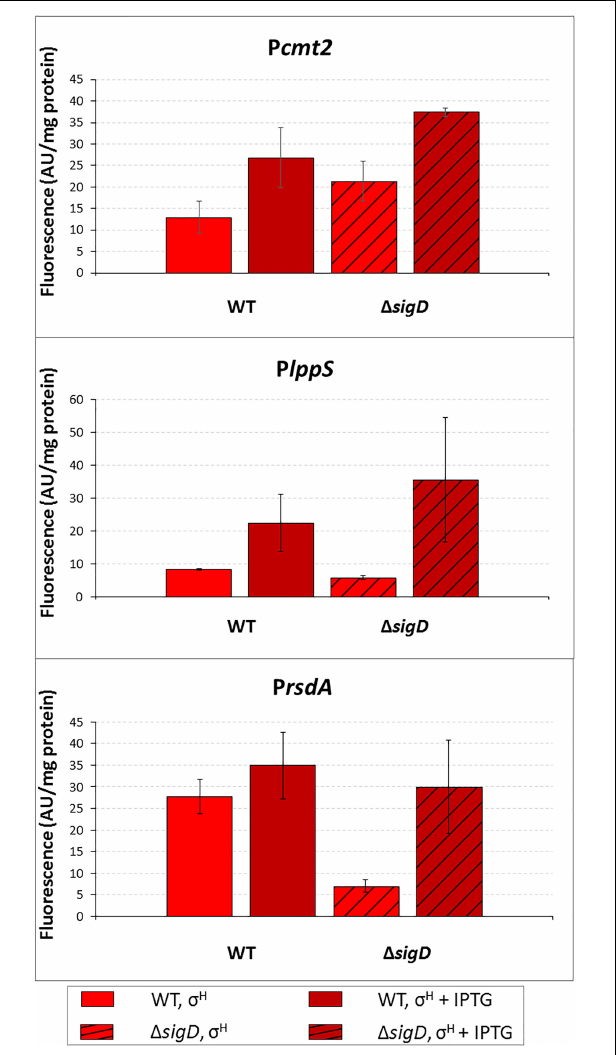
FIGURE 4 | Determination of promoter activity in C. glutamicum WT and (cid:49) sigD strains under sigH overexpression conditions using the two-plasmid assay. The C. glutamicum strains carried the vector pEC-XT99A construct overexpressing sigH with IPTG and the promoter-test vector pEPR1 with a target promoter P cmt2 , P lppS or P rsdA . The promoter activity was measured as the Gfpuv fluorescence intensity of the cell extracts after 6-h growth on complete agar plates with or without IPTG. Fluorescence of cultures without IPTG are shown as light bars; fluorescence of cultures with IPTG induction are shown as dark bars. Open bars depict fluorescence of the strains with WT background, hatched bars depict fluorescence of the strains with the (cid:49) sigD background. AU, arbitrary units. The standard deviations of three biological replicates are depicted by error bars. (cloned in pEPR1), moreover, only on a solid agar medium. The increase in promoter activity, (induction ratio of WT and (cid:49) sigD strains with sigH overexpressed), was 2.1 and 1.8, respectively, for P cmt2 , 2.2 and 3.5, respectively, for P lppS and 1.1 and 6.1, respectively, for P rsdA ( Figure 4 ). Thus, RNAP + σ H was apparently directly active in transcription from all three tested σ D -dependent